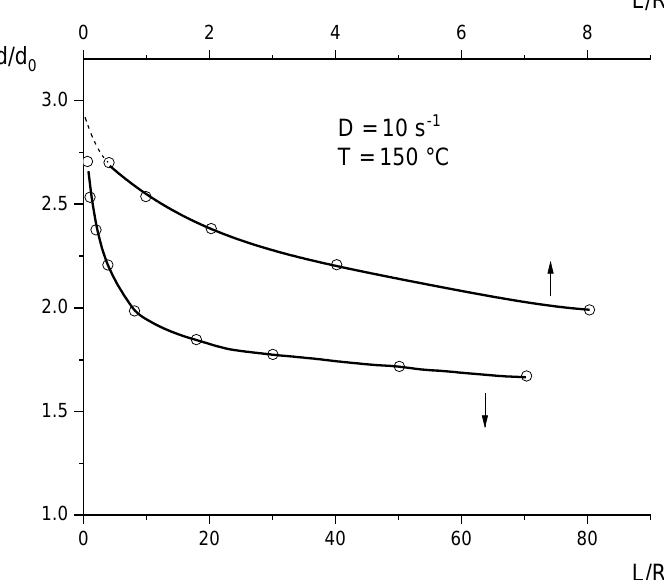
Figure 11. Extrudate swell d / d 0 as a function of the length to radius ratio L / R for an LDPE extruded at the apparent shear rate D = 10 s − 1 through a capillary with the radius R = 1.5 mm [25]. The upper curve and L / R-axis represent the extrudate swell for the smaller L / R at higher resolution.